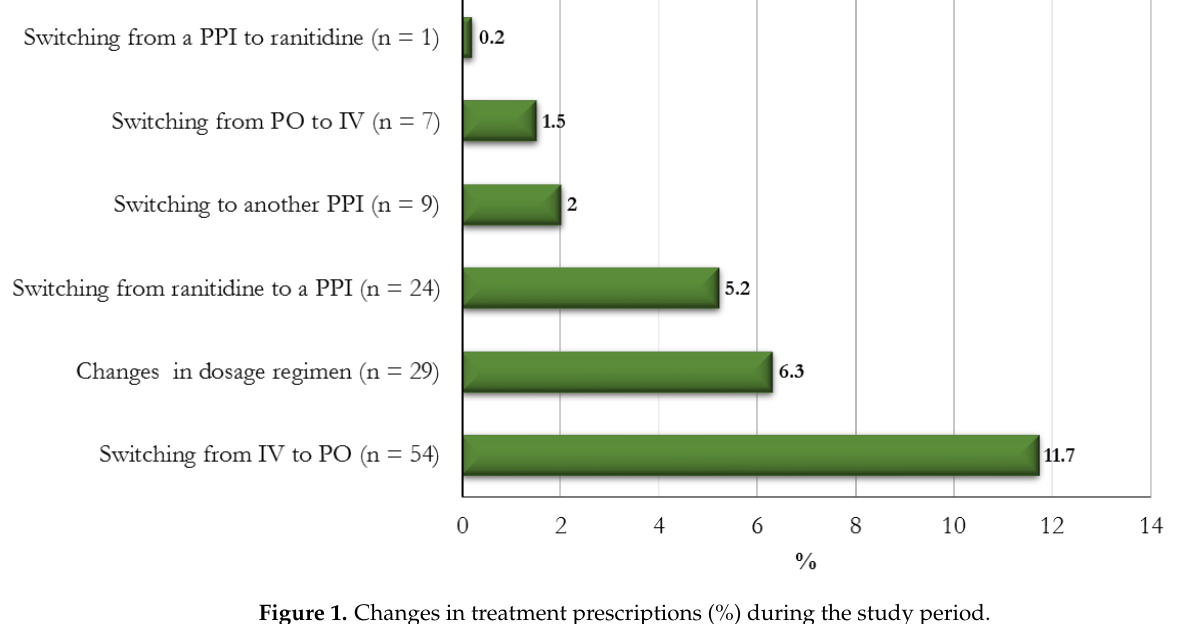
Figure 1. Changes in treatment prescriptions (%) during the study period.